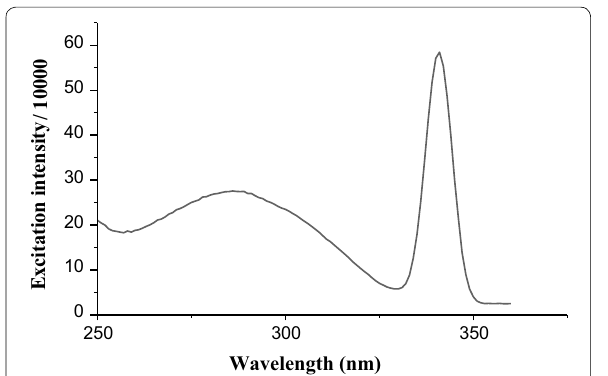
intensity and x indicates concentration). The quantitative amount of caffeine in aqueous solution of green coffee bean (mg/L) was then determined using the calibration curve. Finally, the percentage of caffeine (Table 1) was calculated by taking the mass of caffeine calculated from the linear calibration curve. The fluorescence excitation spectrum of coffee beans dissolved in water is shown in Fig. 8. One can clearly see that the maximum absorb- ance–wavelength of standard caffeine in water (Fig. 6) and coffee dissolved in water (Fig. 8) are almost the same. The differences in the peak area are due to differences in the concentration of caffeine.